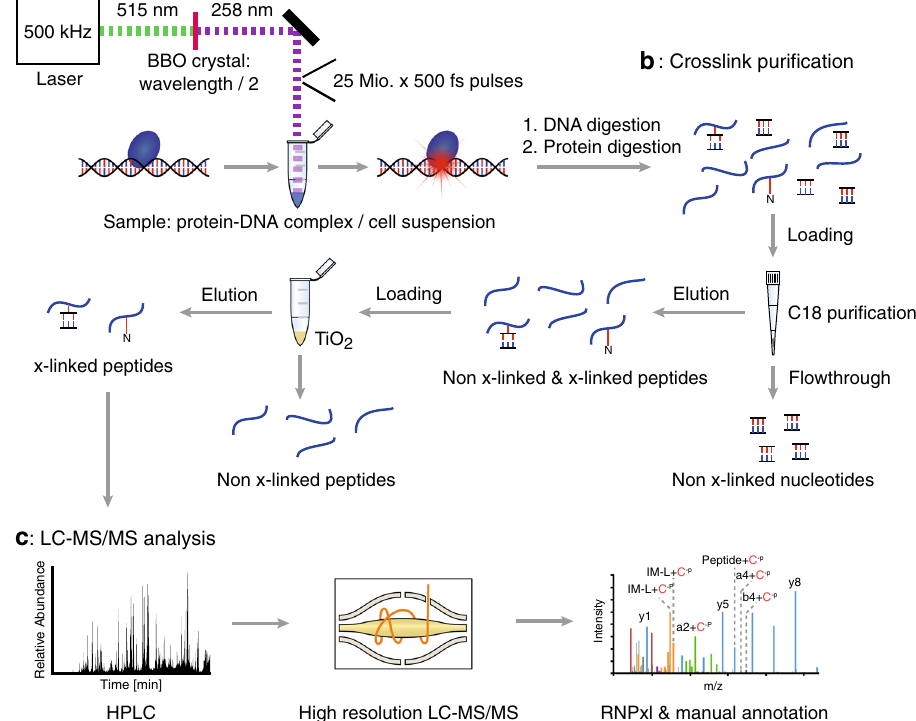
Fig. 1 Schematic work fl ow of the fl iX-MS pipeline. a A pulsed laser beam was generated using a femtosecond fi ber laser with 515 nm wavelength, repetition rate of 0.5 MHz, and pulse duration of 500 fs. The wavelength was doubled to 258 nm by second harmonic generation (SHG) over a beta barium borate (BBO) crystal and the laser beam adjusted to fi t the inner diameter of a regular 1.5 ml Eppendorf tube. b Protein – DNA complexes were irradiated or left untreated as control. Samples were denatured, DNA digested to mono/short oligonucleotides by a mix of Mnase, DNase I, and Benzonase, and proteins digested to peptides by trypsin and Lys-C. Peptides and peptide – nucleotide cross-links were separated from free DNA on C18 StageTips 25 , and cross-links subsequently enriched with TiO 2 beads. c Peptides were measured by LC – MS/MS and data analyzed with the RNP(xl) software package implemented in the proteome discoverer software 50 followed by manual annotation of candidate